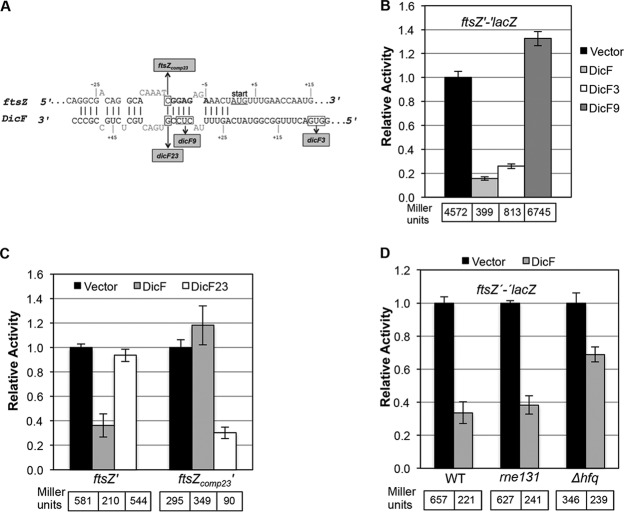
Genetic and molecular characterization of DicF-ftsZ mRNA interactions. (A) Base pairing predictions for ftsZ mRNA and DicF. The numbers for ftsZ are relative to the start codon (with A as +1). The numbers for DicF are relative to the 5′ end of dicF. The predicted ftsZ RBS is shown in bold, and the start codon is underlined. The predicted base pairing interactions between ftsZ and DicF are marked by vertical lines, and mutations in dicF and ftsZ are indicated by boxes. All mutations were substitutions, and boxed residues were changed to the complementary nucleotides. Nonpaired nucleotides or gaps are indicated by sequences above or below paired nucleotides. (B) The β-galactosidase activities of the ftsZ′-′lacZ fusion strains ectopically producing DicF, DicF3, or DicF9 were assayed. (C) The β-galactosidase activities of the ftsZ′-′lacZ fusion and the compensatory ftsZcomp23′-′lacZ fusion were assayed upon overexpression of DicF and DicF23. (D) The levels of β-galactosidase activity of the ftsZ′-′lacZ fusion in the wild-type (WT) strain and in the rne131 and hfq mutants were assayed after overexpression of DicF. The specific activities of the fusions were normalized as described for Fig. 2.